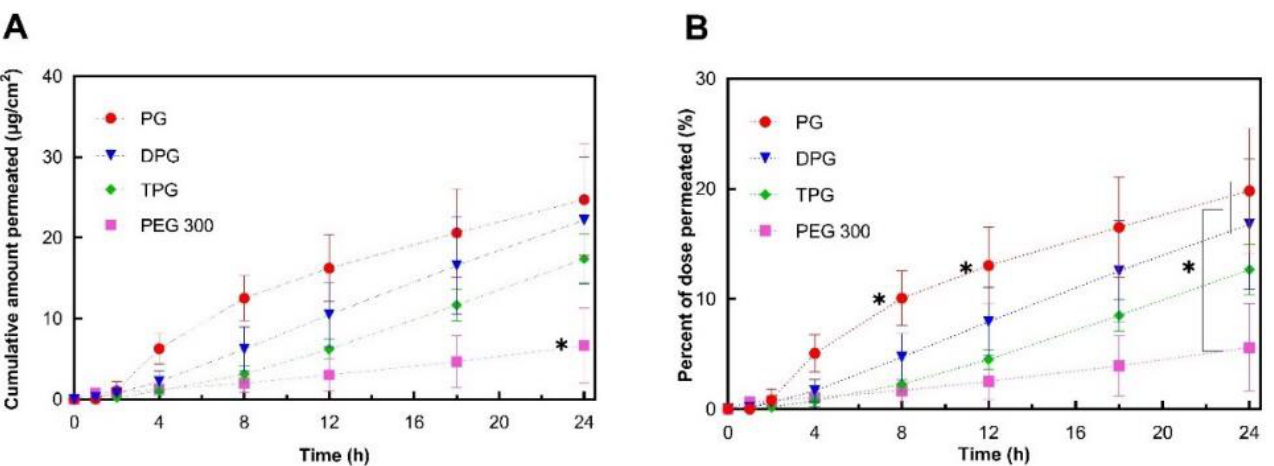
Figure 2. Permeation profiles of IBU in human epidermis after application of 5% IBU formulations expressed as ( A ) cumulative amounts (μg/cm 2 ) and ( B ) percentages (%) of the dose applied (mean ± SD; 5 ≤ n ≤ 6, * p < 0.05).